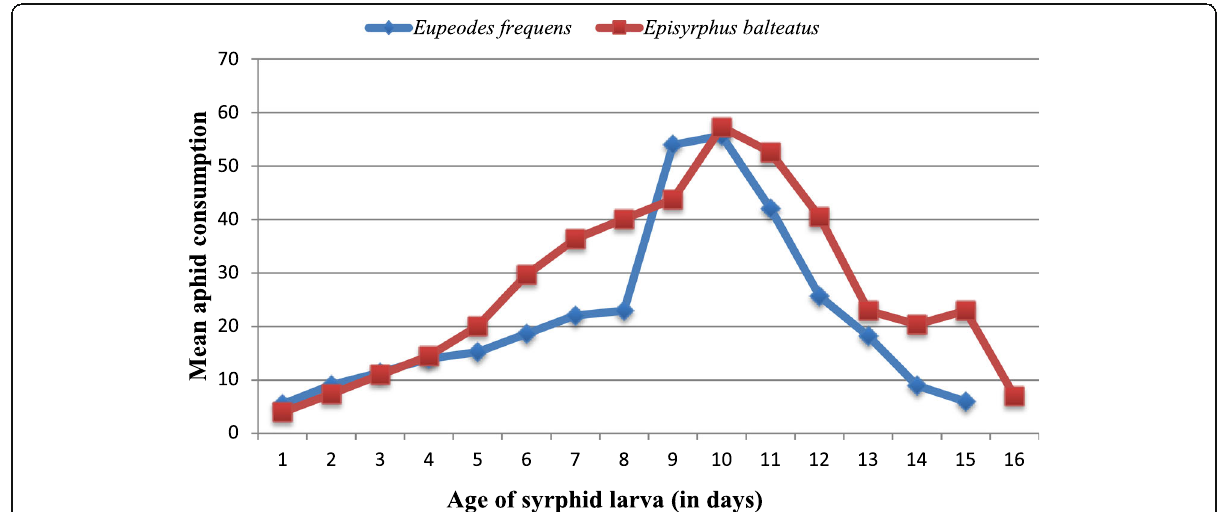
Fig. 1 Trend of daily consumption by Eupeodes frequens and Episyrphus balteatus on Brevicoryne brassicae till pupation (signs indicate mean values of 10